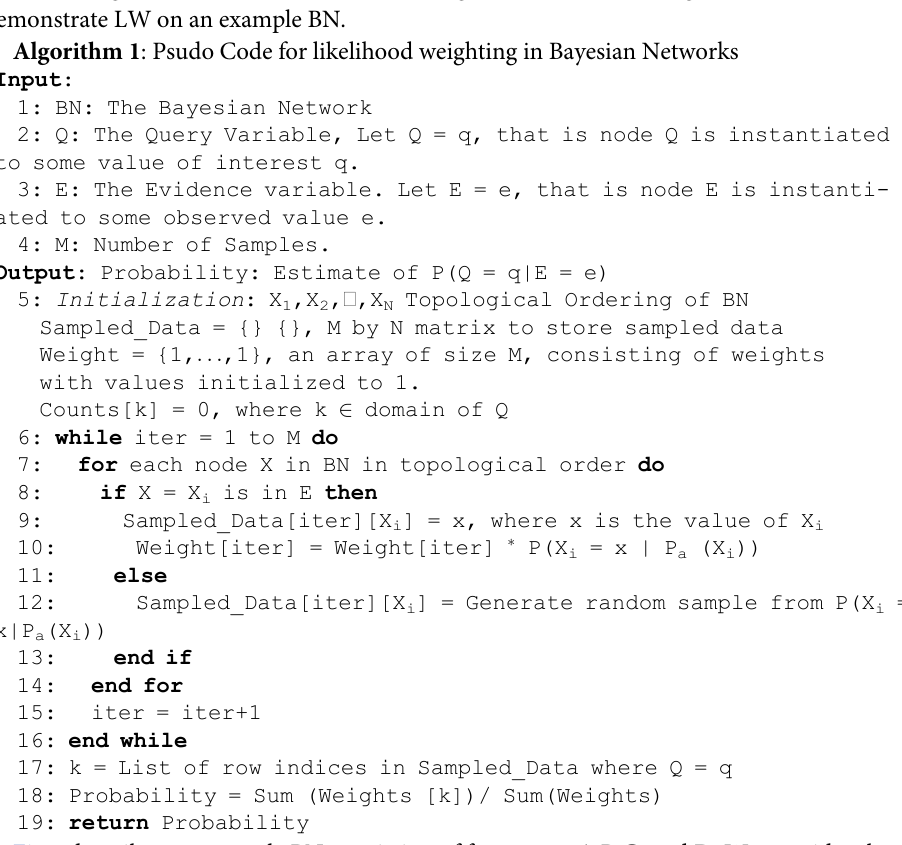
Algorithm 1 : Psudo Code for likelihood weighting in Bayesian